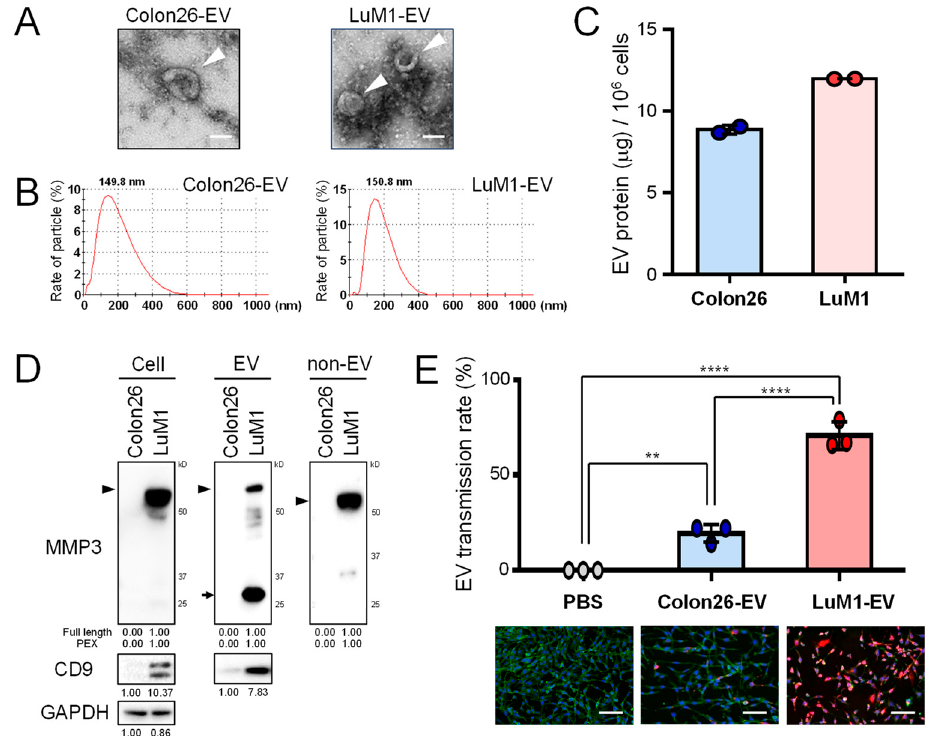
Figure 1. Metastatic tumor-derived, matrix metalloproteinase 3 (MMP3)-rich extracellular vesicles (EVs) are highly transmissive. The roles of EVs derived from low-metastatic Colon26 cells vs. high-metastatic LuM1 cells were compared. ( A ) Representative TEM images of EVs. Arrowheads indicate EVs with cup-shaped morphology. Scale bars, 100 nm. ( B ) Particle diameter distribution of EV fractions. ( C ) EV protein release from Colon26 vs LuM1 cells. EV protein concentrations ( µ g per 10 6 cells) were shown. ( D ) Western blot analysis of MMP3 and CD9 in cell lysates, EV and non-EV fractions. Arrowhead indicates full-length MMP3 (54 kD). Arrows indicate the 25-kD PEX isoform of MMP3. For MMP3, the protein amount equivalent to 8 × 10 4 cells (Colon26, 0.72 µ g; LuM1, 0.96 µ g) was loaded to each lane. For CD9 and GAPDH, the protein amount equivalent to 1.2 × 10 5 cells (Colon26, 1.09 µ g; LuM1, 1.44 µ g) was loaded to each lane. ( E ) Transmission e ffi ciencies of Colon26-EVs vs LuM1-EVs. EVs were labeled with red fluorescent ceramide and added to culture media of recipient Colon26 cells at a final concentration of 11.5 µ g / mL for 24 h. Cells were fixed and stained with ActinGreen and DAPI. Top, EV transmission e ffi ciencies. The e ffi ciencies were the ratio of transmitted EV-positive cells to the total number of cells. ** p < 0.01, **** p < 0.0001, n = 3 fields. Bottom, representative images of EV transmission. Scale bars, 100 µ m. The experiments were repeated twice in Figure